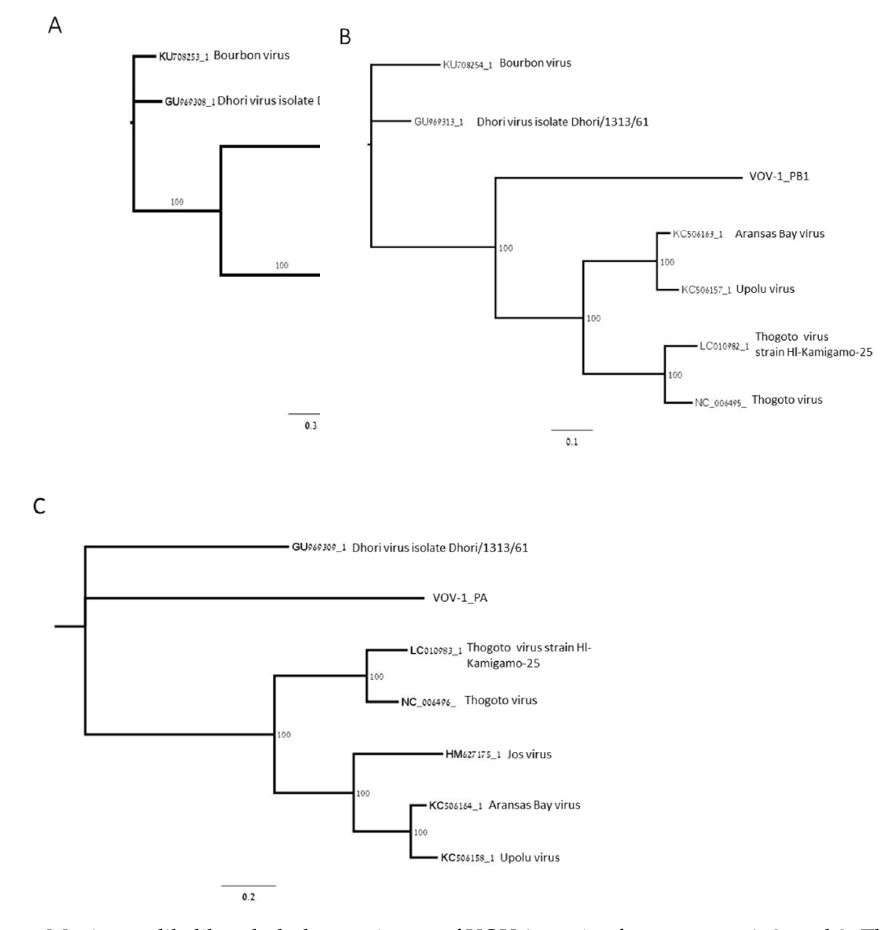
Figure 2. Maximum-likelihood phylogenetic tree of VOV-1 contigs for segments 1, 2, and 3. The trees were constructed based on the ORF of VOV-1 polymerase subunits PB2 ( A ), PB1 ( B ), and PA ( C ). GeneBank accession numbers provided.